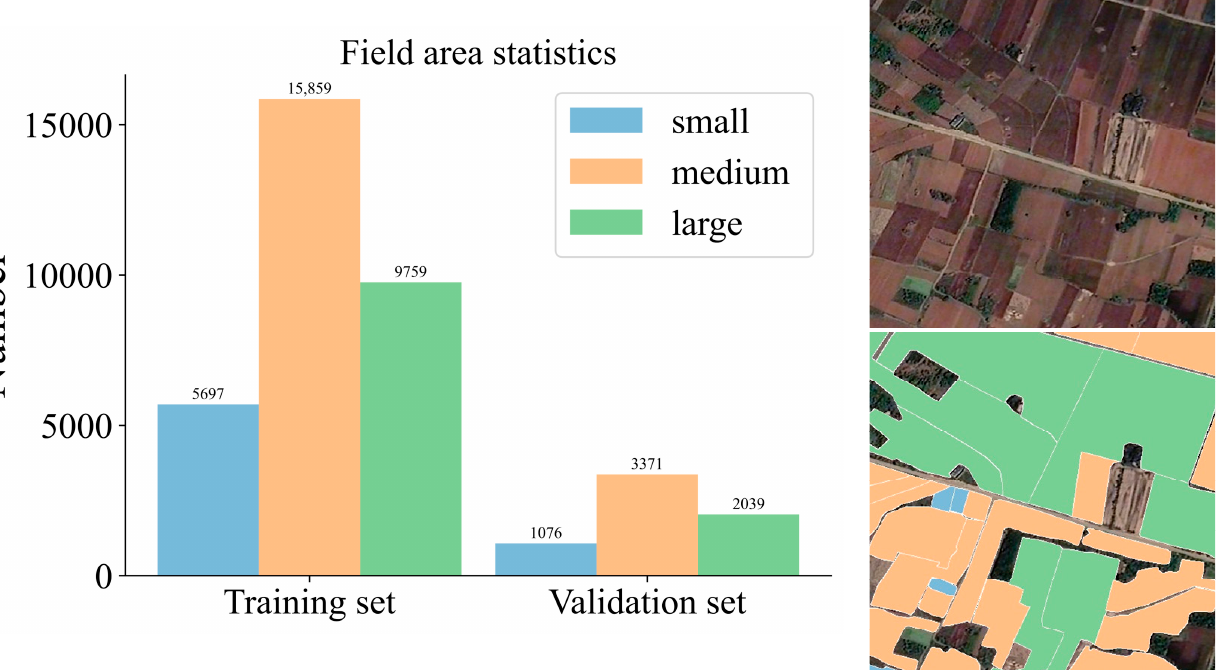
Figure 2. The field area is counted according to three scales: small, medium, and large. The proportion of fields of each scale is about 1:3:2.